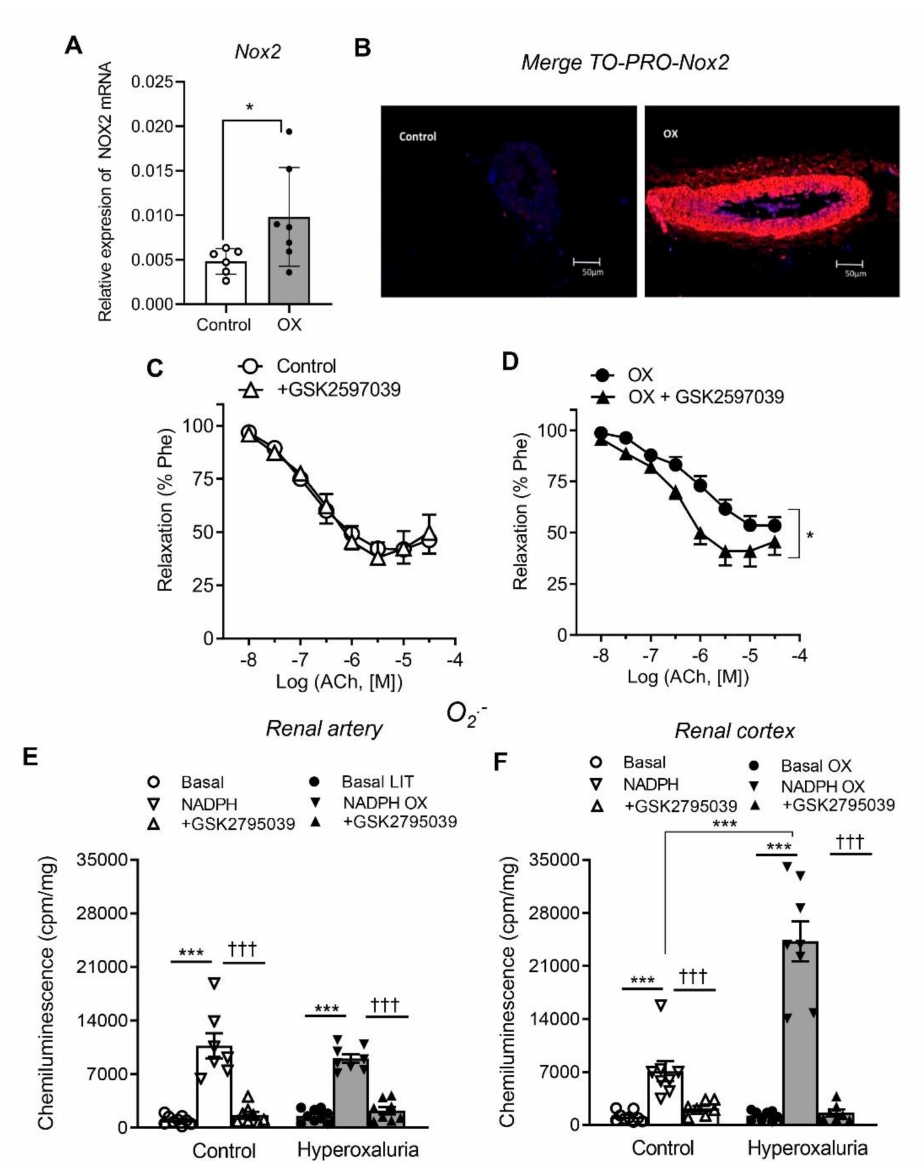
Figure 5. Up-regulation of Nox2 and amelioration of oxidative stress in renal cortex and endothelial dysfunction by selective Nox2 inhibition in preglomerular arteries from hyperoxaluric rats. ( A ) Com- parative Nox2 mRNA expression in samples of renal arteries from the control ( n = 6) and OX group ( n = 6) performed by RT-PCR. The delta CT method was used to determine the fold change for Nox2 gene relative expression in the arteries that were treated with water (control group) and with 0.75% EG (OX group). * p < 0.05. ( B ) Immunofluorescence demonstration of enhanced expression Nox2 protein in a section of a renal interlobar artery from OX group compared to a control artery. Immunofluorescence double labeling for TO-PRO marker (blue areas) demonstrates nuclear staining and for Nox2 protein (red areas). ( C , D ) Comparative effects of the Nox2 inhibitor GSK2795039 on en- dothelial relaxations of rat intrarenal arteries in control ( C ) and OX groups ( D ). Results are expressed as a percent of induced contraction. Data are shown as the mean ± SEM of 4 animals. Statistical differences were calculated by a Student’s t -test for paired observations * p < 0.05 versus control. ( E , F ) Effects of inhibitor GSK2795039 on NADPH-dependent ROS generation in renal arteries and cortex measured by lucigenin-enhanced chemiluminescence. Results are given as counts per minute (cpm) per mg of tissue. Bars represented mean ± SEM of 5–10 animals. Statistical differences were calculated by Student t -test *** p < 0.001 versus basal levels. ††† p < 0.001 versus NADPH-stimulated